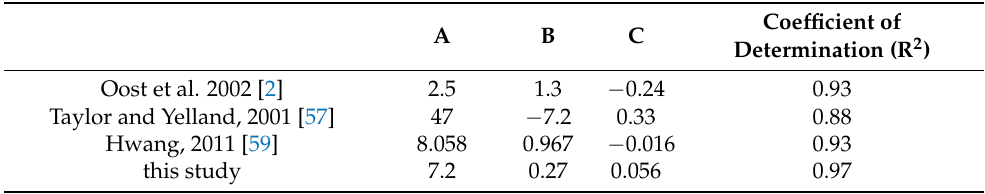
Table 2. The values of constants A – C in Equation (10) using Chinese-French Oceanography SATellite (CFOSAT) wind speeds and calculated sea roughness by Equations (8) and (9) using CFOSAT- measured winds and waves.